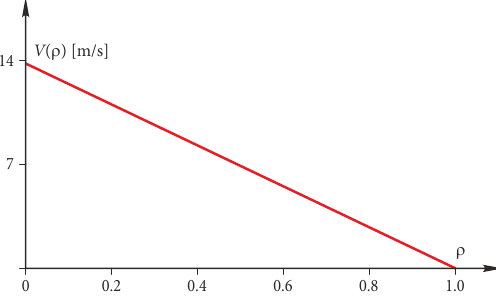
Fig. 2. V ( r ) velocity–density function with e 1 = 1; e 2 = 1; e Table 1. Demonstration of the e parameter vector Meaning of the Unfavourable e i parameter cases